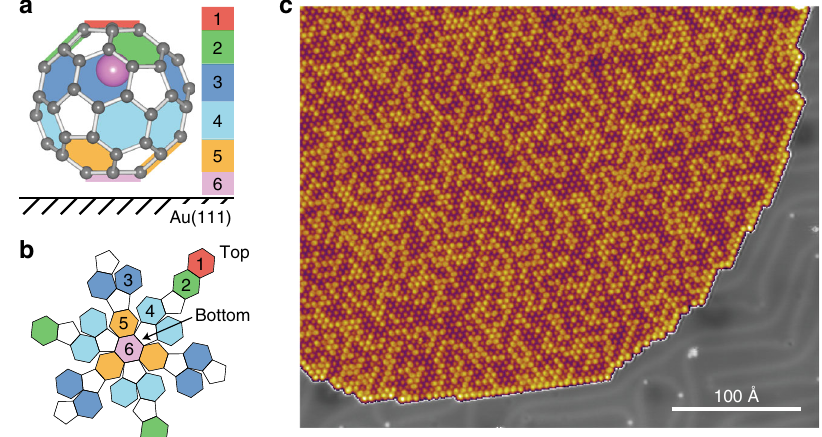
Fig. 1 The Li@C 60 molecule on a Au(111) surface. Ball-and-stick models of a Li@C 60 molecule adsorbed on a surface as seen a from a side perspective, and b as a deconstructed diagram (without the Li). For a colour-coded Schlegel diagram of a C 60 see Supplementary Note 1. The model in a shows the off- centre displacement of the Li atom when in level 1. c STM image of a large hexagonally close-packed molecular island on the Au(111) surface. Image acquired at + 1.0 V, 0.1